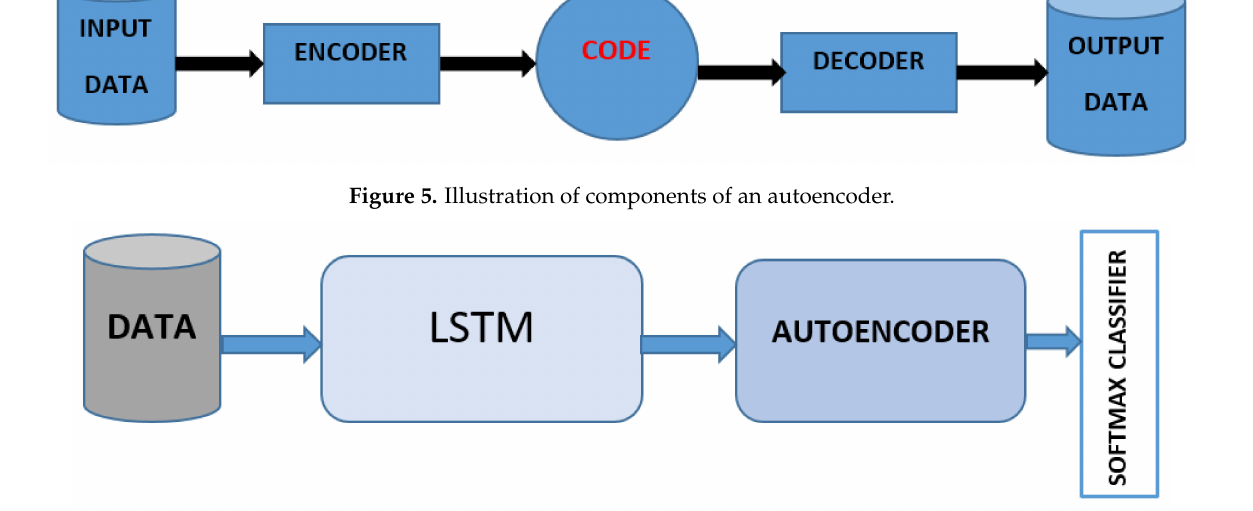
Figure 6. An architectural view of the LSMTAE